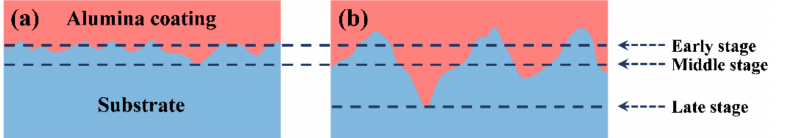
Figure 10. Schematic diagram of the penetration process of corrosive liquid in coatings with different substrate roughness: ( a ) 5 µ m; ( b ) 20 µ m.